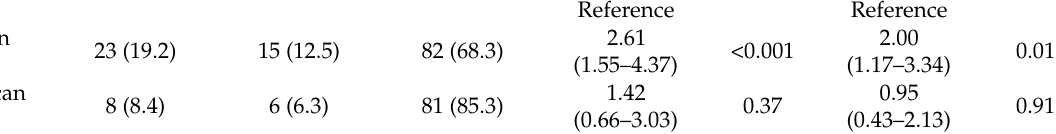
Table 4. Associations between race/ethnicity and radical nephrectomy.